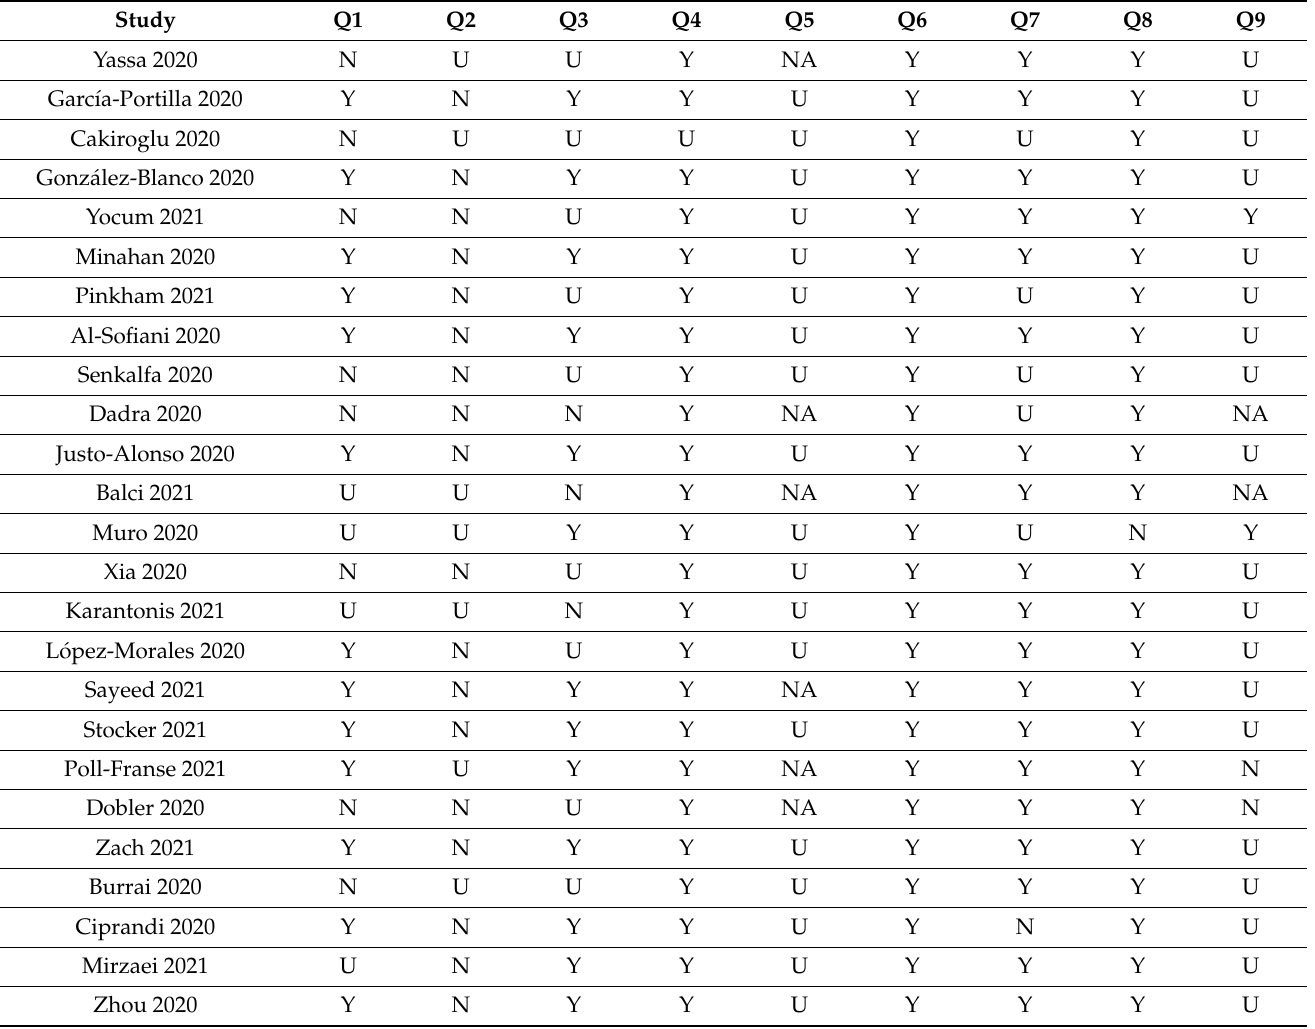
Table 2. The risk of bias of included